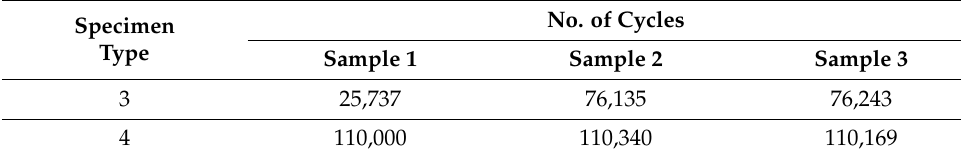
Table 4. Summary of the fatigue test results.